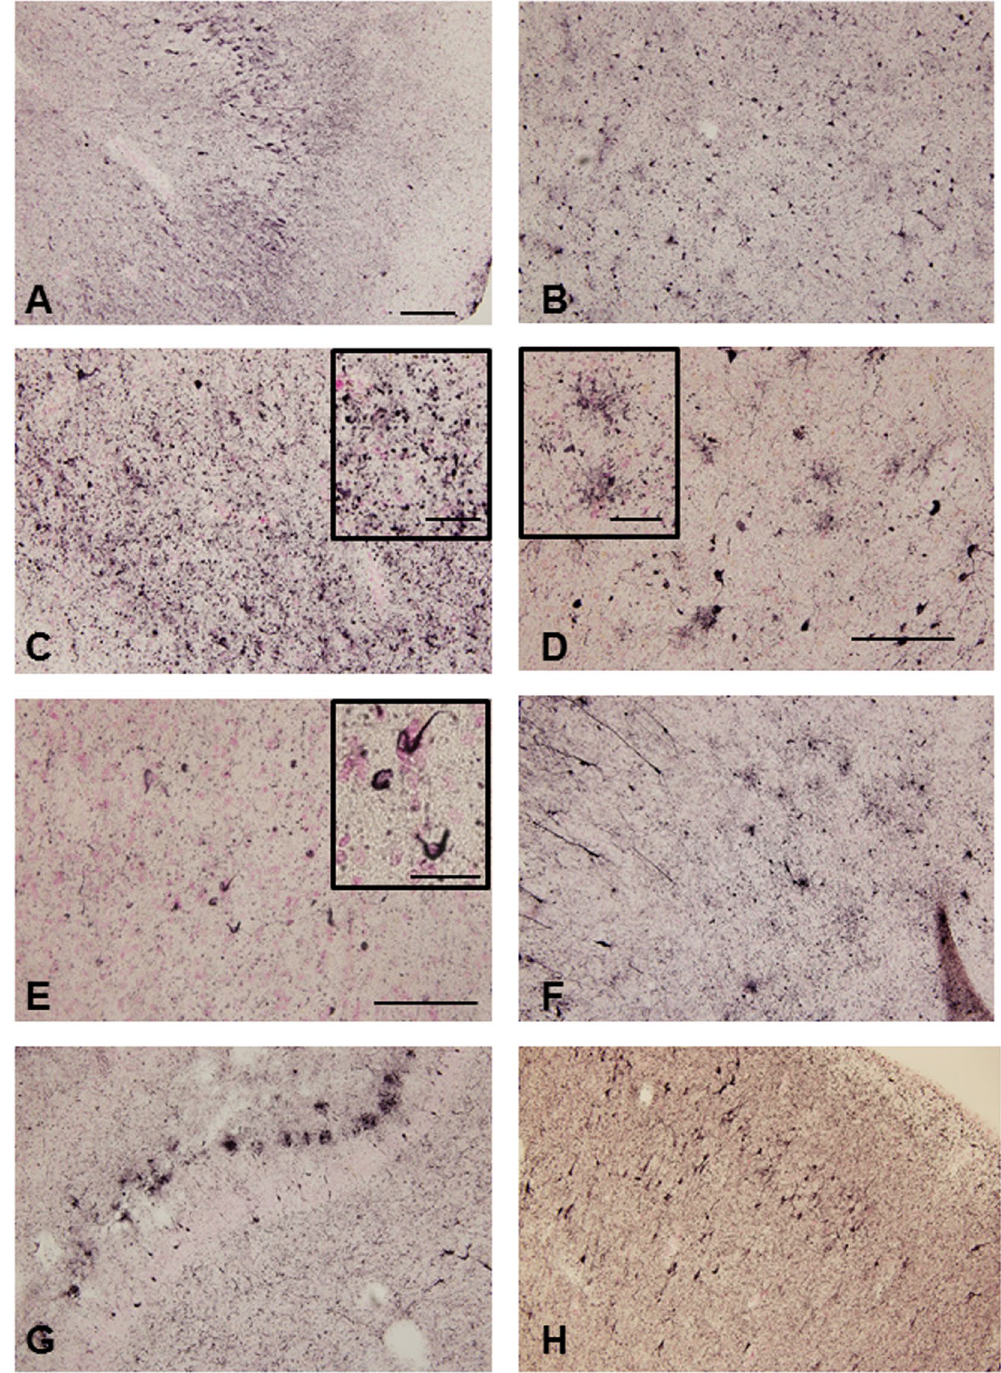
Figure 2. Photomicrograph of phosphorylated tau immunohistochemistry of the temporal lobe of the GRN mutation cases. Massive AT8-positive structures were observed in the hippocampus ( A ), amygdala ( B ), inferior temporal cortex ( C ) in case 2. AT8-positive astrocytes were observed in the temporal cortex ( D ) and AT8- positive oligodendrocytes in the white matter of temporal lobe ( E ) in case 2. AT8-positive deposition was also detected in amygdala in case 1 ( F ), hippocampus in case 3 ( G ) and entorhinal cortex in case 4 ( H ). The sections were counterstained with Kernechtrot stain solution. The scale bar in A applies to ( B , C , D , F , G and H ) (200 μ m), in E (100 μ m), respectively. The scale bars in the inserts are 50 μ m ( C and D ) and 25 μ m ( E ),